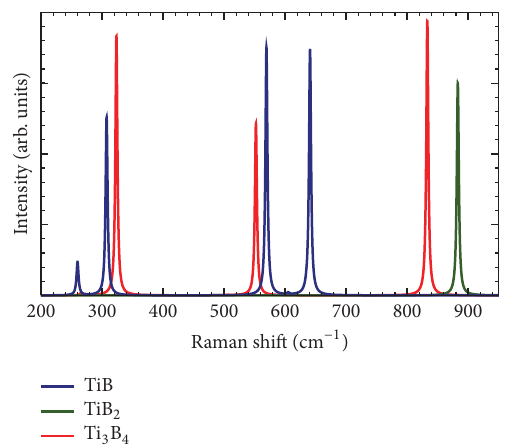
Figure 7: Unpolarized Raman spectra of TiB, TiB 2 , and Ti 3 B 4 poly- crystals calculated at backscattering geometries. Spectra are simu- lated at 300 K and with laser excitation wavelength of 532 nm. Peaks are represented by Lorentzian functions with artificial FWHMs of 2 cm −1 .